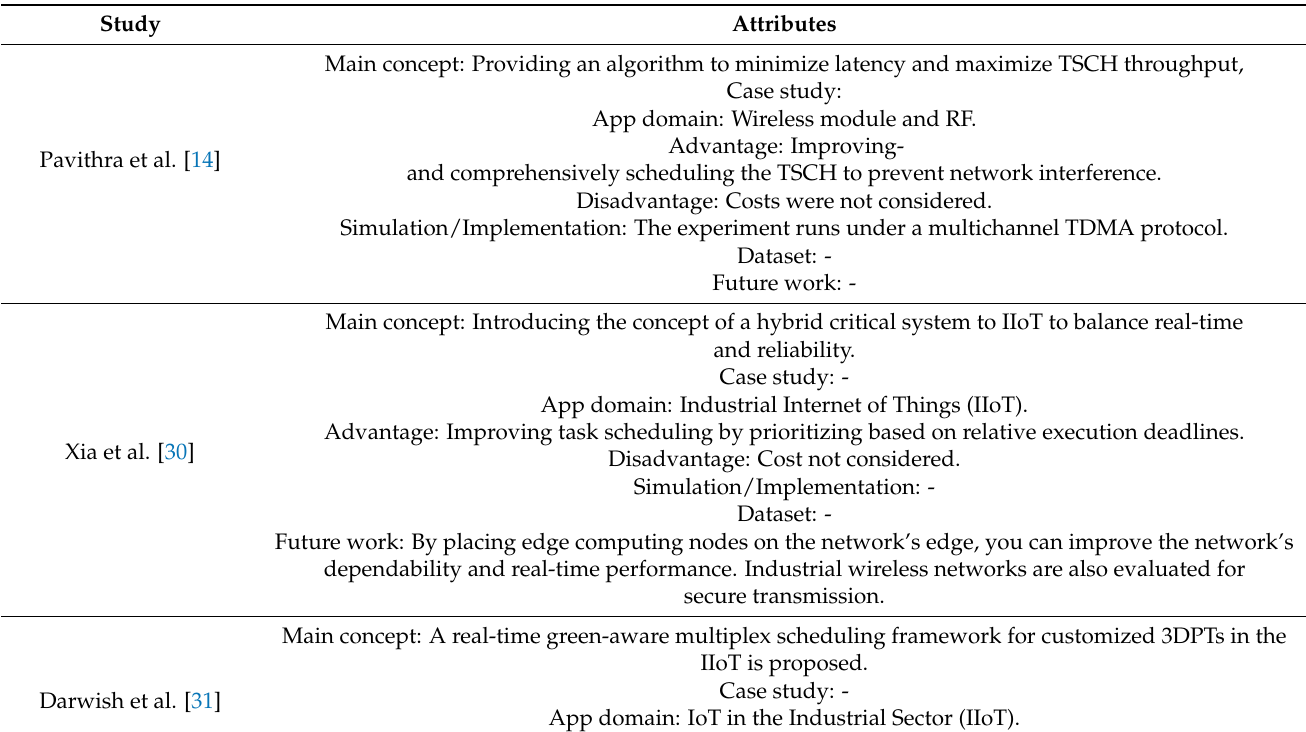
Table 6. Categorizing the state-of-the-art in smart grid